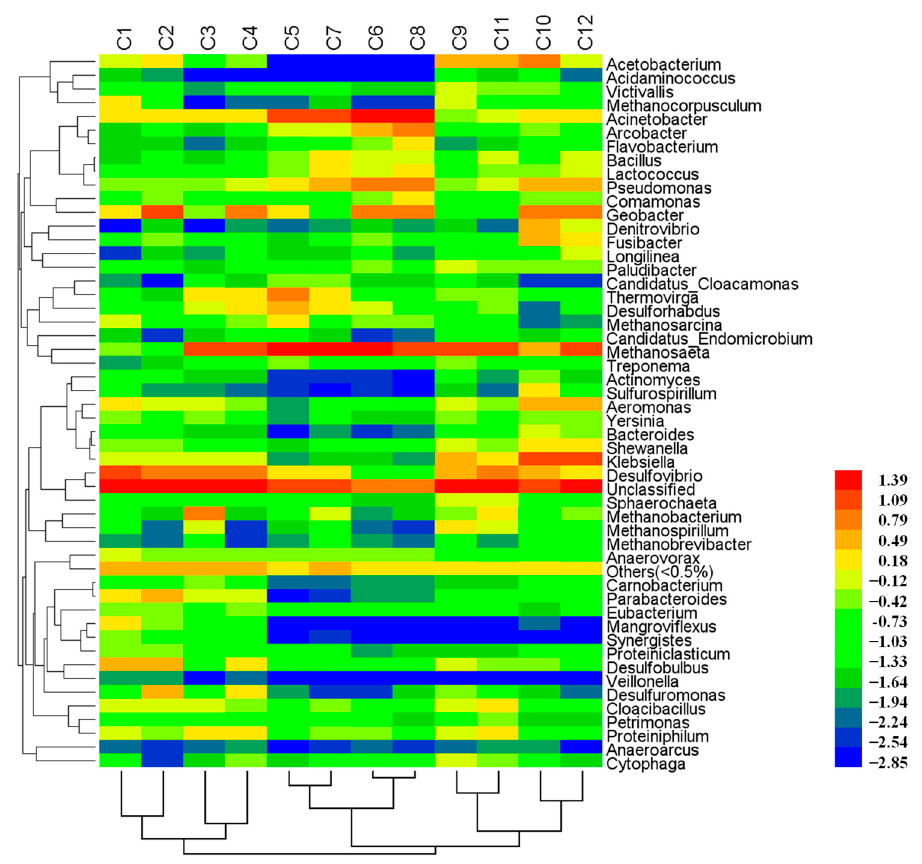
Figure 4. Hierarchical cluster analysis of microbial communities 12 biofilm samples.